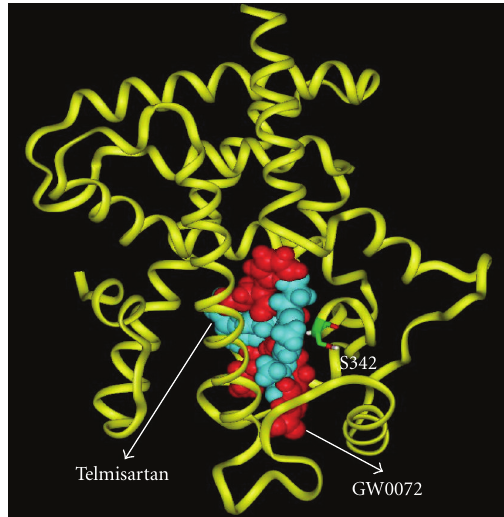
Figure 1: Telmisartan (blue) superimposed on the co-crystal struc- ture of GW0072 (red) bound within the PPAR γ -LBD. Telmisartan and GW0072 are Van der Waals space-filling representations, and the protein backbone by the yellow ribbon. Formation of hydrogen bonds and interactions between both ligands and the amide proton of Ser342 contribute toward stabilization of the partial agonists within the PPAR γ -LBD. ( Kindly provided by Dr. P.V. Desai & Professor M.A. Avery, Department of Medicinal Chemistry, University of Mississippi, USA .)